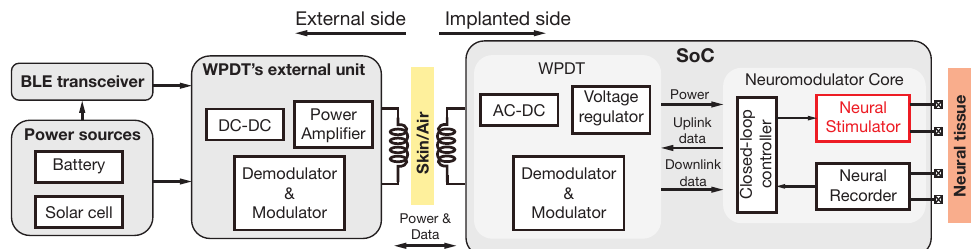
Figure 1. Simplified block diagram of the wirelessly powered neural implant, including power sources, a Bluetooth Low-Energy (BLE) transceiver, Wireless Power and Data Transfer (WPDT) external and internal units, and neuromodulation System on Chip (SoC). The circuit presented in this work is drawn in